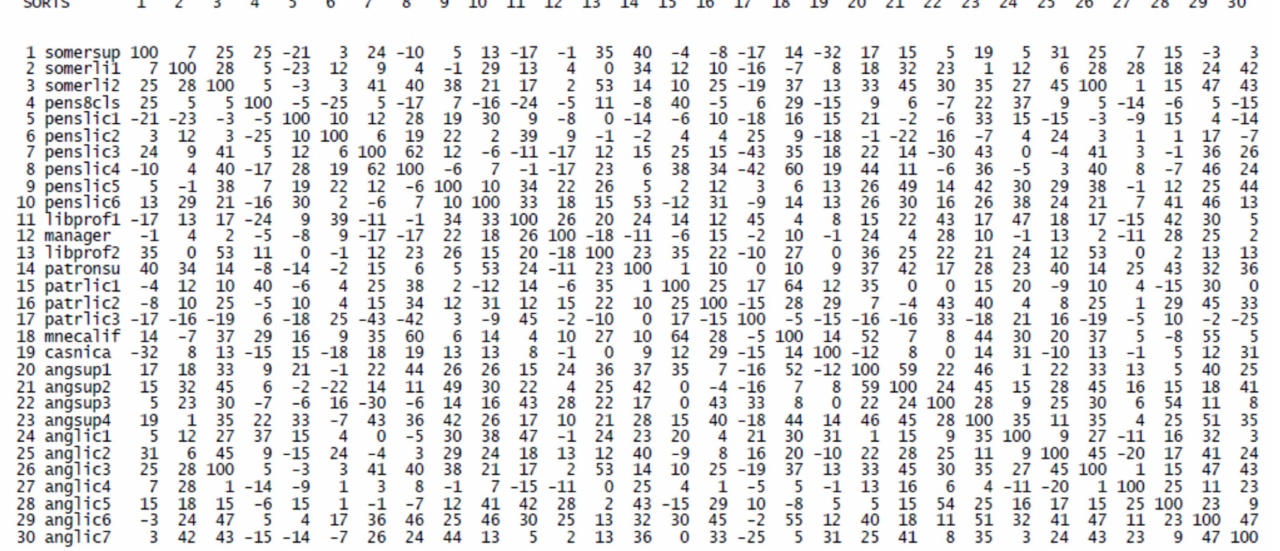
Figure A1. The correlation matrix based on completed Q-sorts using the